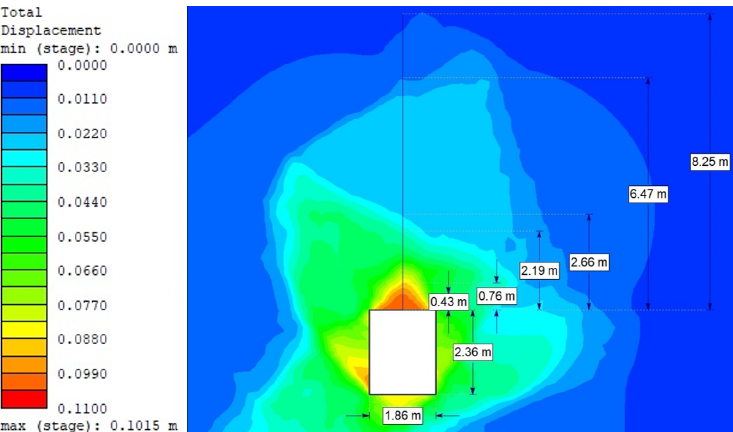
Figure 12. Total strains for Vernier stringers without bolting (Coulomb–Mohr